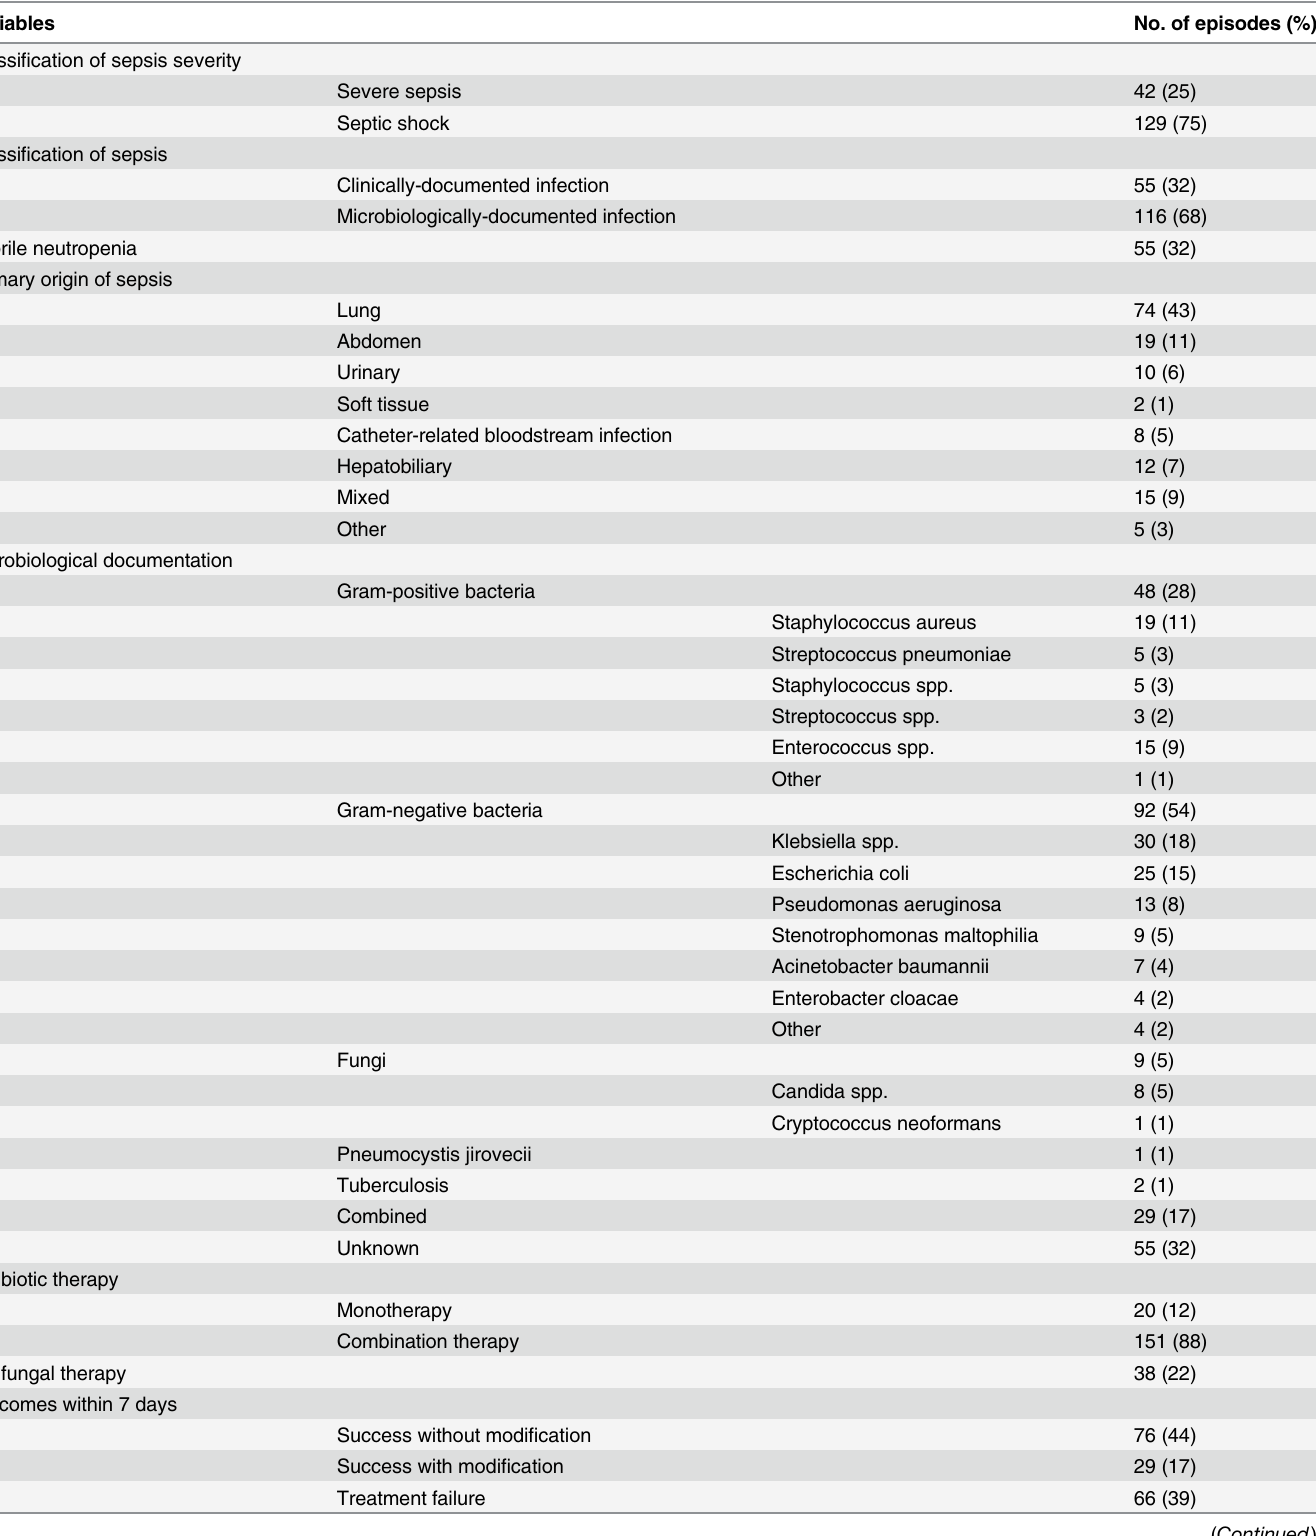
Table 2. Episode